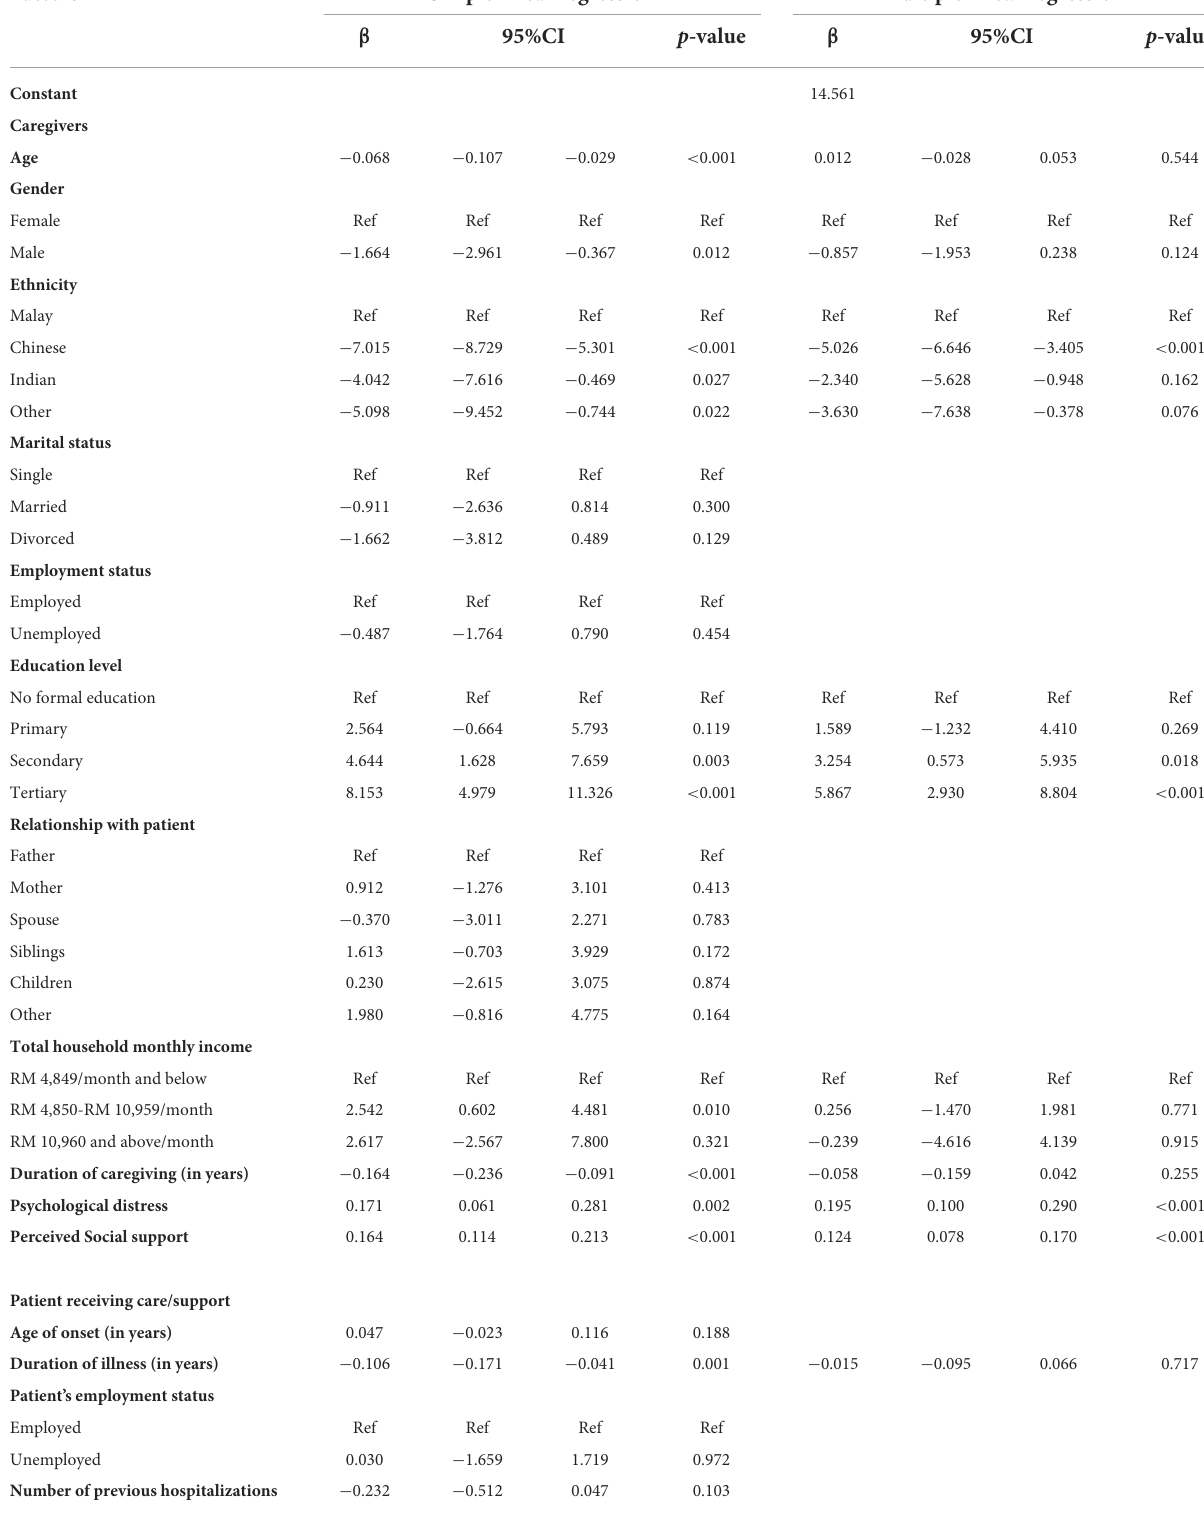
TABLE 5 Factors associated with emotion focus coping strategies among caregivers of patients with schizophrenia. Factors Simple linear regression Multiple linear